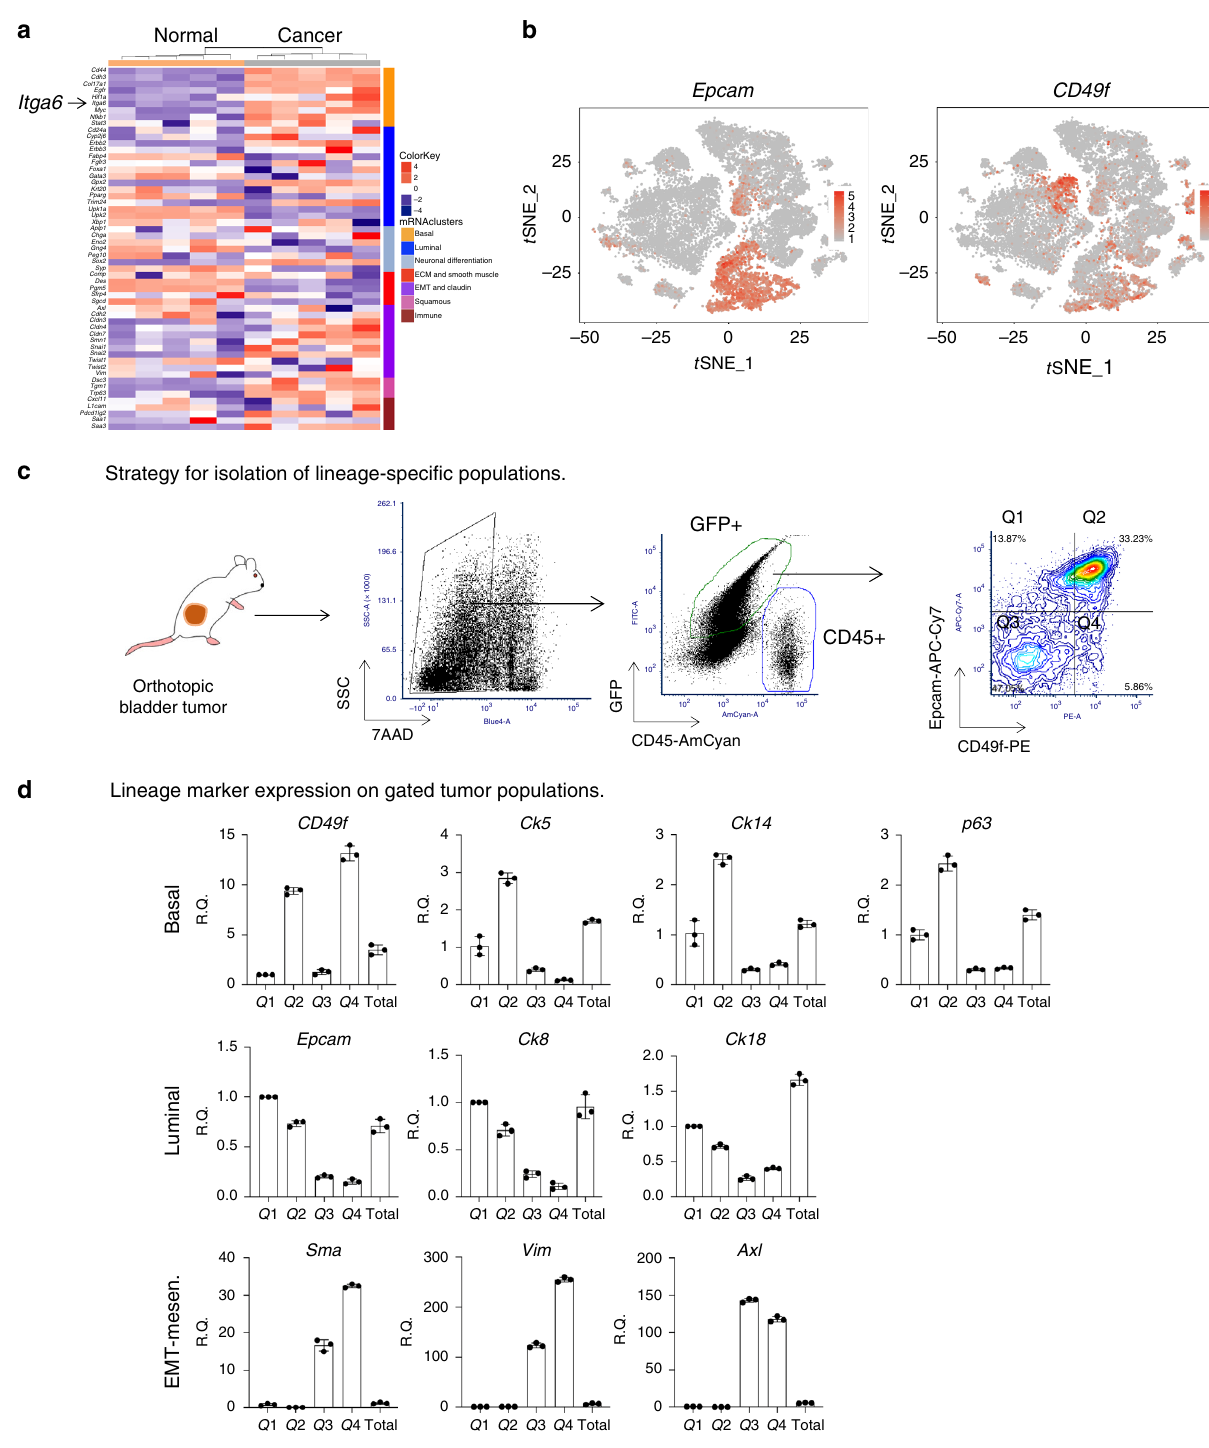
Fig. 4 Identi fi cation of CD49f ( Itga6 ) as a differentially expressed cell surface marker in OHBBN-induced bladder tumors. a Bulk RNA-seq analysis showing differentially expressed genes belonging to various lineage subtypes in the normal bladder ( n = 5) and OHBNN induced bladder cancer ( n = 5). The surface antigen, CD49f ( Itga6 , arrows), is overexpressed in bladder tumors and found within the basal mRNA cluster. b tSNE cell clusters 3, 5, 8, and 11 de fi ning Epcam (left) and CD49f ( Itga6 ) expression. c Strategy for discriminating GFP-positive, CD45-negative OHBBN-induced cancer cells from non- tumor host cells in FVB/NJ-transplanted mice. Tumor cells are evaluated for expression of Epcam and CD49f, and de fi ne lineage populations within de fi ned quadrants (Q1, Q2, Q3, and Q4). d Differential gene expression for lineage subtypes using Epcam-CD49f expression in cell populations of GFP-positive; CD45-negative tumor cells sorted from quadrants Q1, Q2, Q3, and Q4. Individual data points are represented by circles, the error bars represent mean ± SD of the three independent replicates. Each experiment was performed at least in